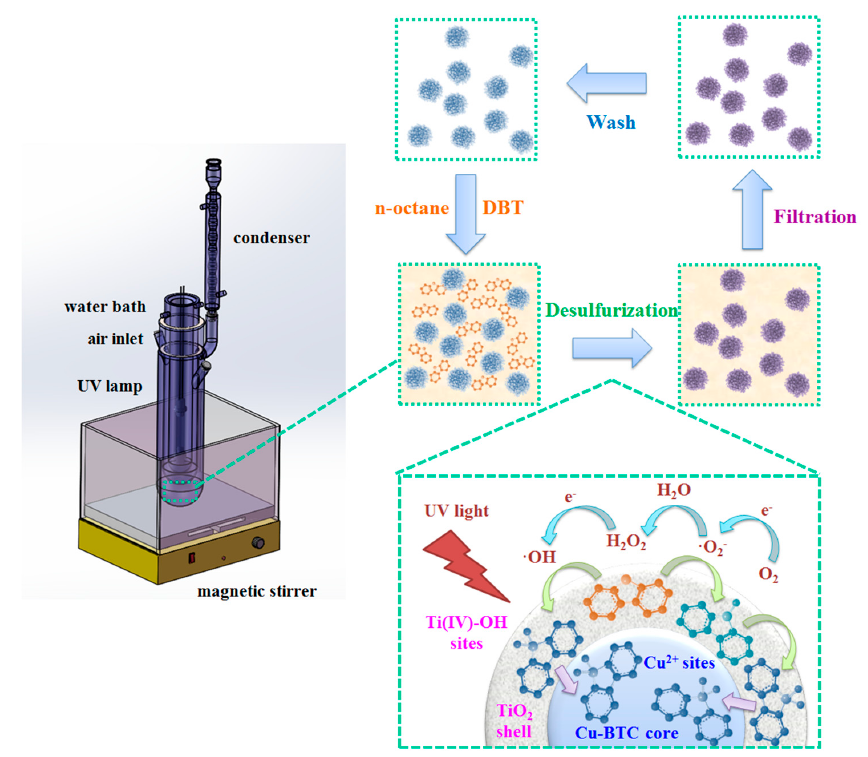
Figure 9. Schematic of the desulfurization mechanism of Cu-BTC@TiO2 microspheres.